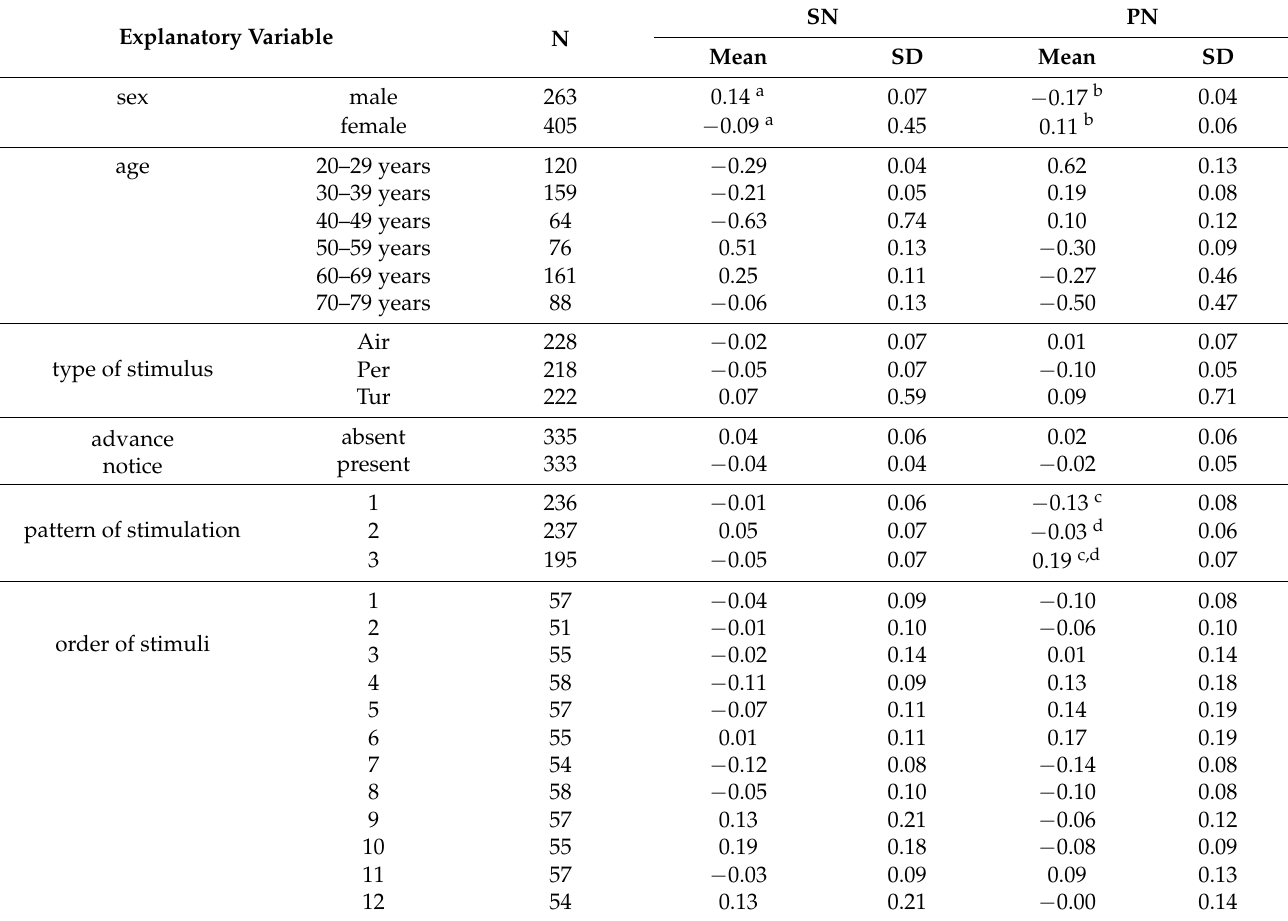
Table 2. The mean values of SN and PN for each